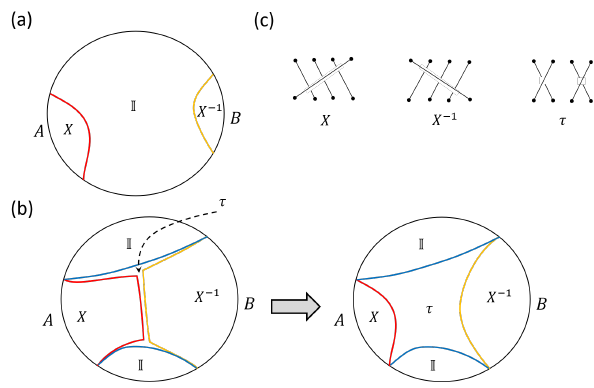
Figure 2 . The domain configuration in the case that (a) I RT ( A : B ) = 0 and (b) I RT ( A : B ) > 0 . The red and orange curves are RT surfaces of A and B , respectively, while the blue curves in (b) are the RT surface for AB . The RT surfaces are domain boundaries, with the value of g x in each domain indicated on the figure. (c) Illustration of permutation X, X − 1 and an example of τ in (b). There are multiple τ which contribute identically to the action (see